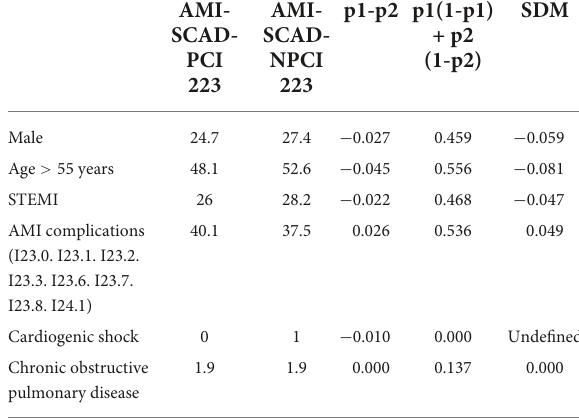
TABLE 2 Multilevel logistic regression model of risk adjustment for in-hospital mortality.